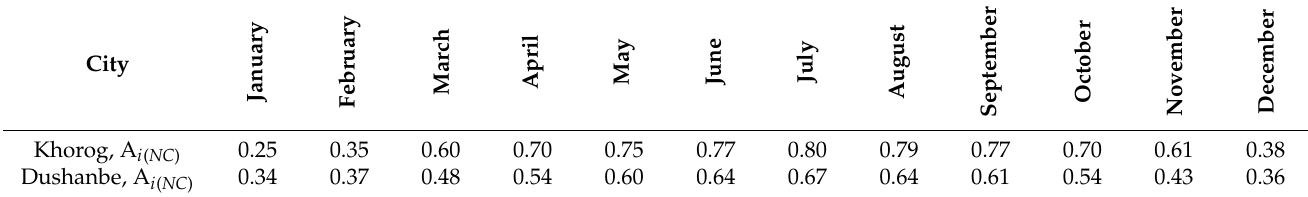
Table 3. The calculated values of the generalized uncertainty coefficient for the second object.